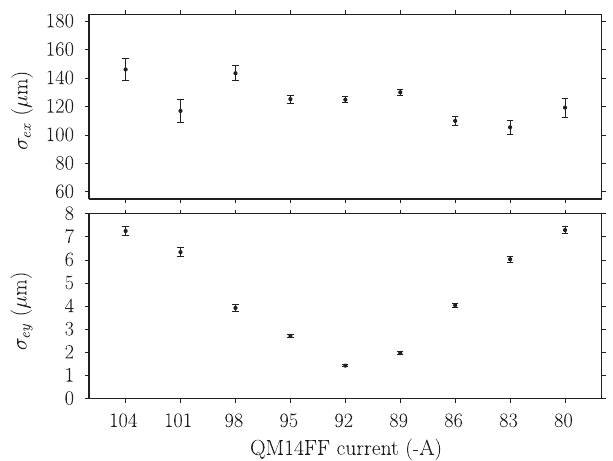
FIG. 22. Horizontal (top) and vertical (bottom) electron beam sizes measured by the laserwire using combined analysis for various currents of QM14FF, the vertical focusing quadrupole immediately before the LWIP.